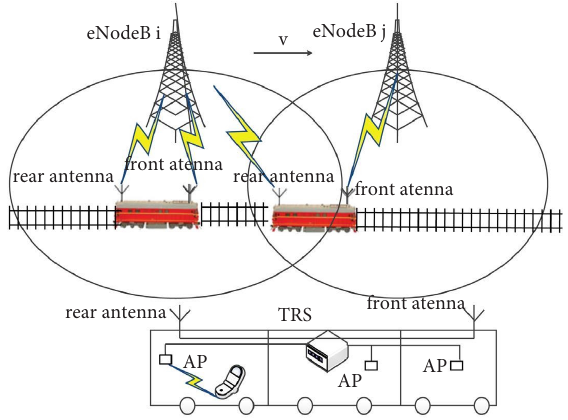
Figure 1: Dual-link system